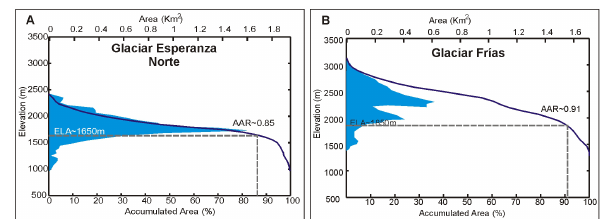
Fig. 8. Comparison of the hypsometry of Glaciar Esperanza Norte and Glaciar Fr´ıas. The elevation data were derived from the SRTM V4 Digital Elevation Model. Blue areas indicate the distribution of glaciated area with elevation in the year 2007 and purple lines in- dicate cumulative surface areas for each glacier. Note the elevated AAR values determined for both glaciers.